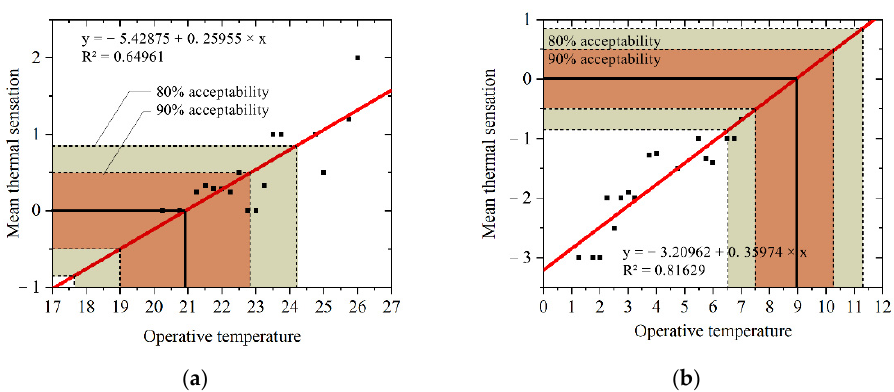
Figure 4. The relationship between MTS and the operative temperature. ( a ) Summer, ( b )